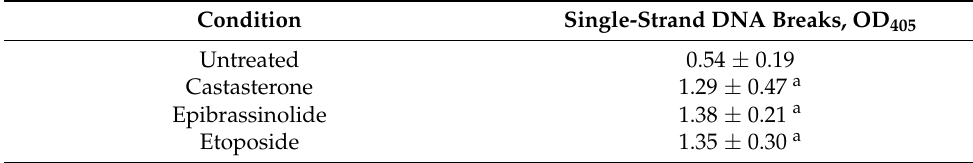
Table 3. DNA fragmentation induced by castasterone